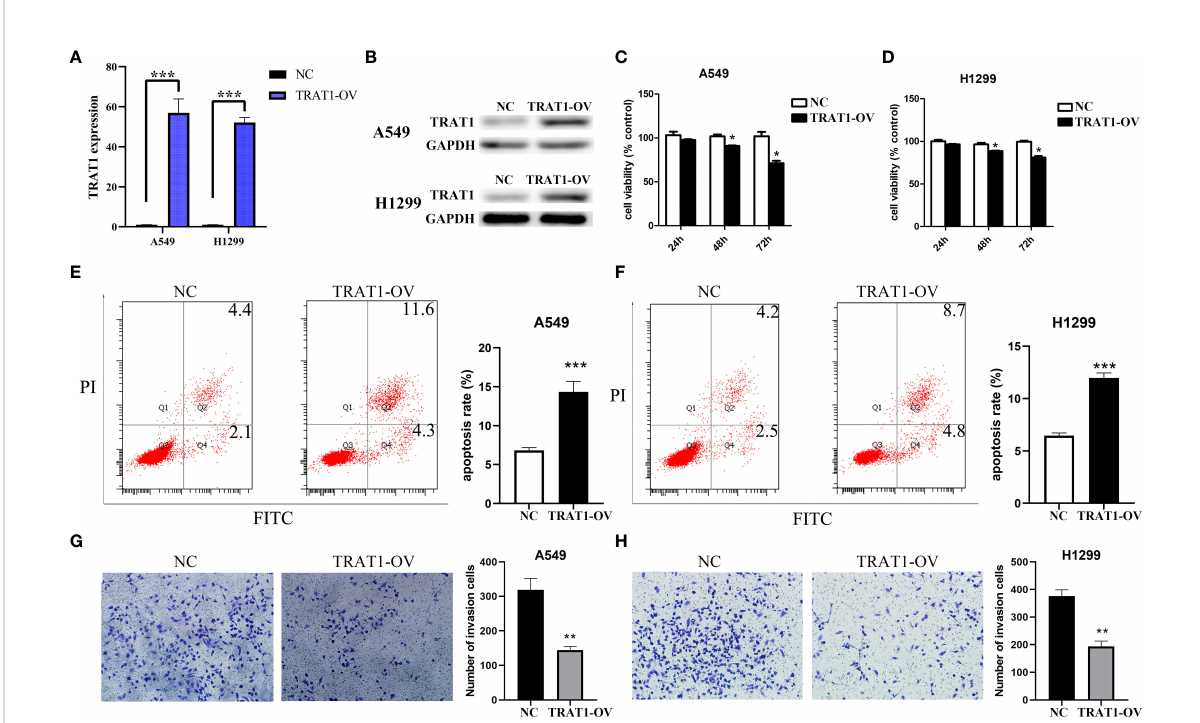
FIGURE 6 TRAT1 overexpression inhibited the cell growth and immune invasion in LAC cell models. (A, B) Construction of A549 and H1299 cell models of TRAT1 overexpression using the PCR and Western Blotting; (C-F) Decreased cell viability and increased apoptosis in TRAT1 overexpression group determined using the CCK-8 assay and fl ow cytometry; (G, H) Decreased cell invasive ability in TRAT1 overexpression group determined using the transwell experiment. LAC, lung adenocarcinoma; CCK-8, Cell Counting Kit-8; *P < 0.05; **P < 0.01; ***P < 0.001.